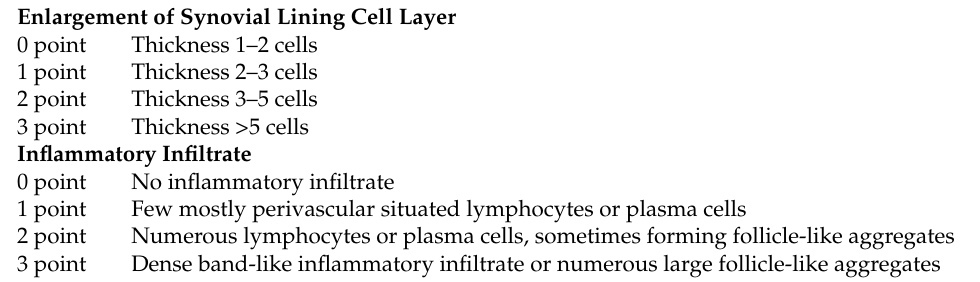
Table 1. Histopathological assessment of synovitis